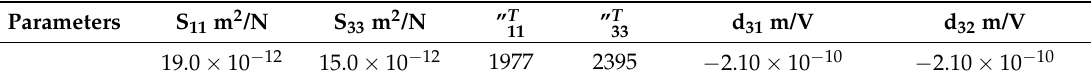
Table 1. Materials properties of the piezoelectric